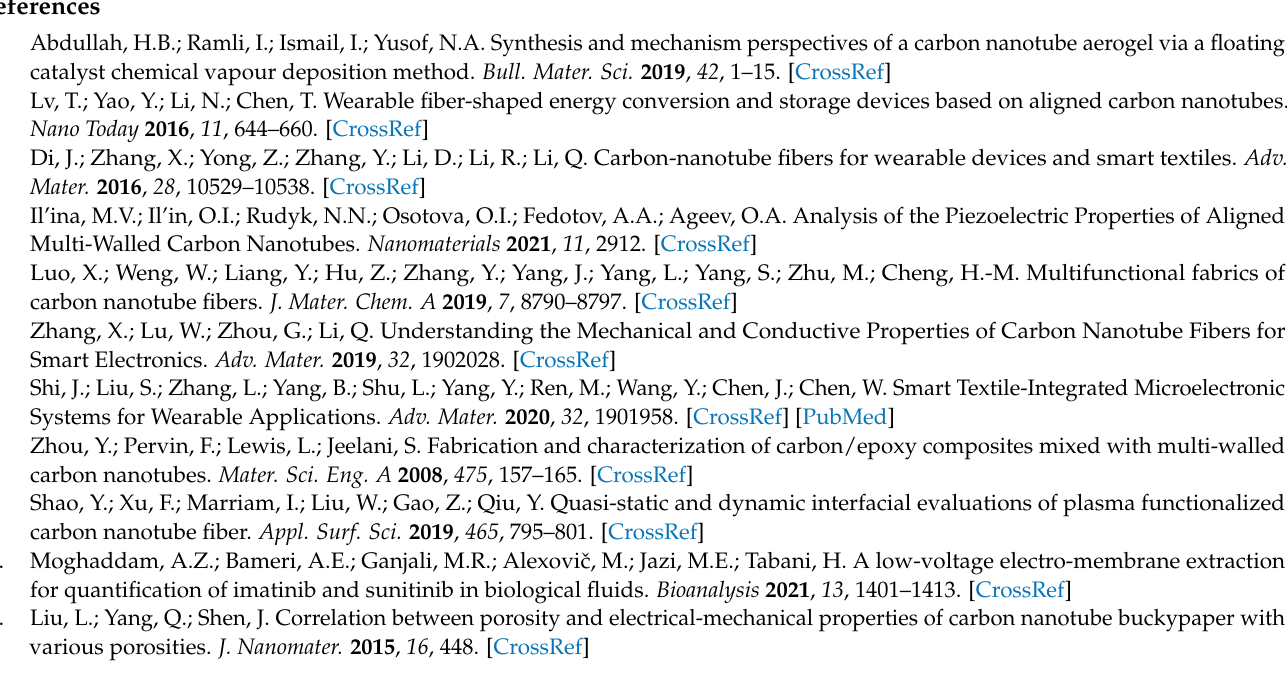
Figure S2: TGA of CNT yarn in Nitrogen